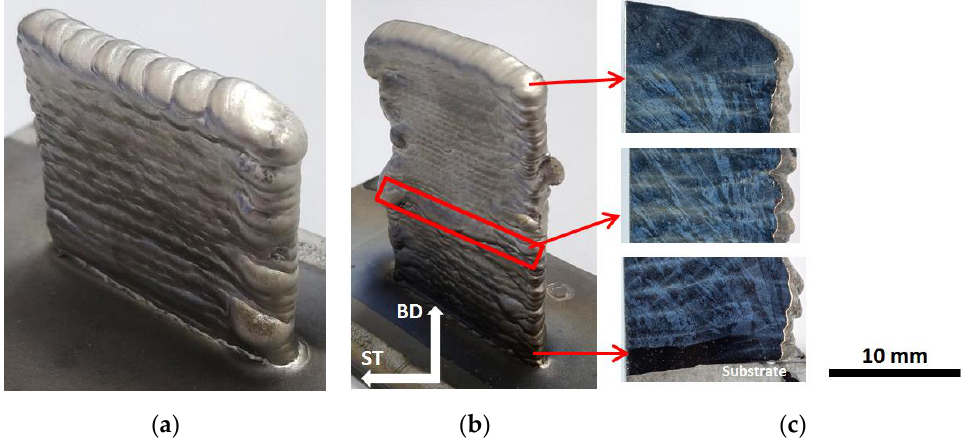
Figure 4. General view of the initial ( a ) and the repaired ( b ) product, macrostructure of the product material in the longitudinal section ( c ). BD — build direction, ST — scanning trajectory. The closed red line shows the transition region.